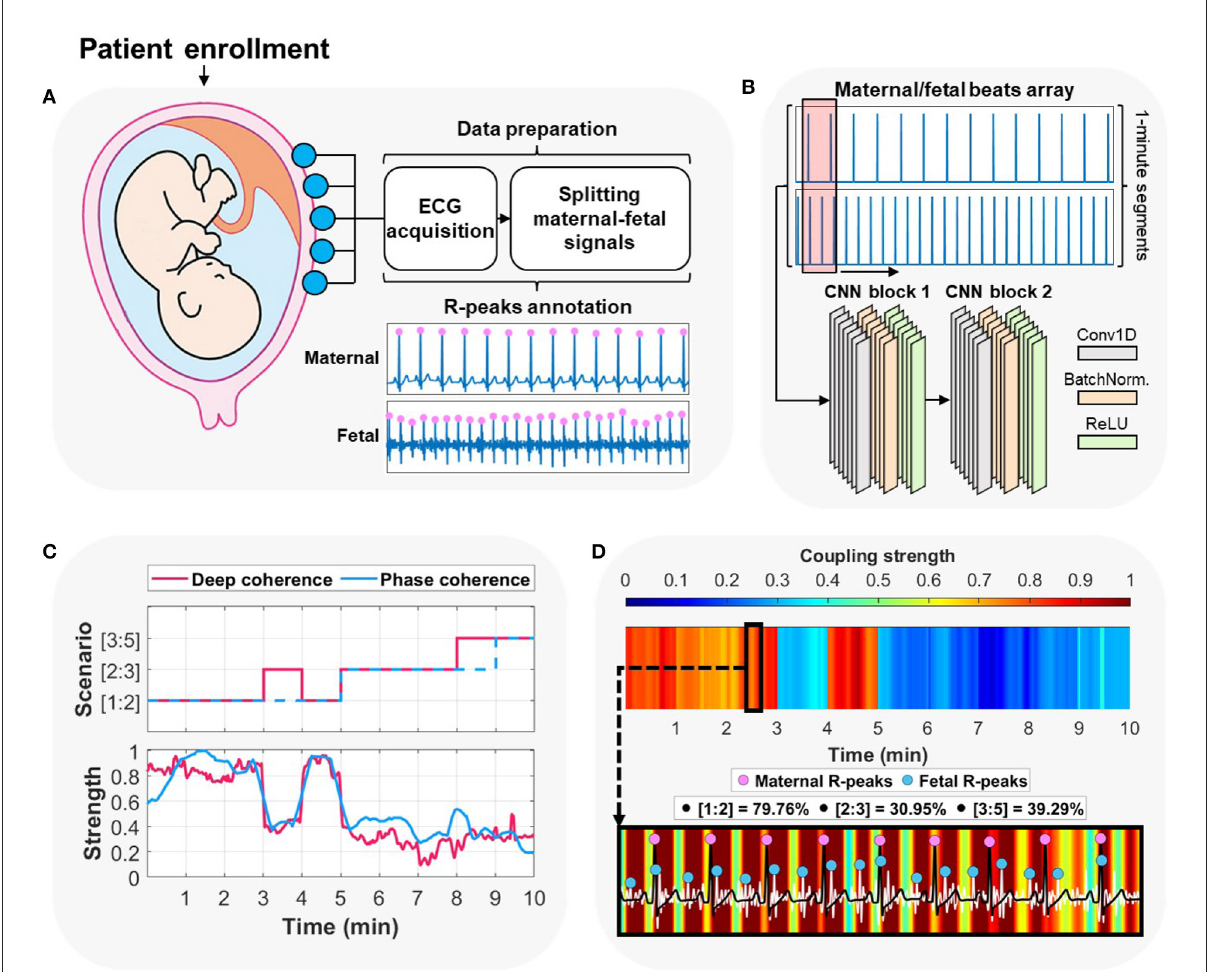
FIGURE1 Overview of the proposed approach for maternal-fetal cardiac coupling analysis using deep learning. (A) The procedure started by acquiring abdominal electrocardiography (ECG) recording from the pregnant patient enrolled at the hospital/clinic. The method proceeded by splitting the contaminated maternal-fetal signals and detecting their corresponding R-peaks locations. (B) The second step was arranging the input to per-minute segments of the maternal/fetal combined heartbeats array and feeding it to a two-block convolutional neural network (CNN). (C) The deep learning model was trained on predicting per-minute cardiac coupling scenarios ([1:2], [2:3], or [3:5]). In addition, it allowed for extracting attention to such coupling in a form of a continuous signal using the gradient-weighted class activation mapping (Grad-CAM) technique. We compared deep learning predictions and attentions vs. the ground-truth label (assigned using phase-occurrence counting) and its corresponding phase coherence strength ( λ p ) (see Section 4). (D) Deep learning allows for explaining the decisions by interpreting an overall attention heatmap image which shows the variations of cardiac coupling strength with time. A zoomed-in heatmap allows for observing patterns between maternal and fetal ECG signals alongside their corresponding R-peaks. We show the original prevalence ( % ) of each coupling scenario in the 2–3 minutes time interval (deep learning prediction was